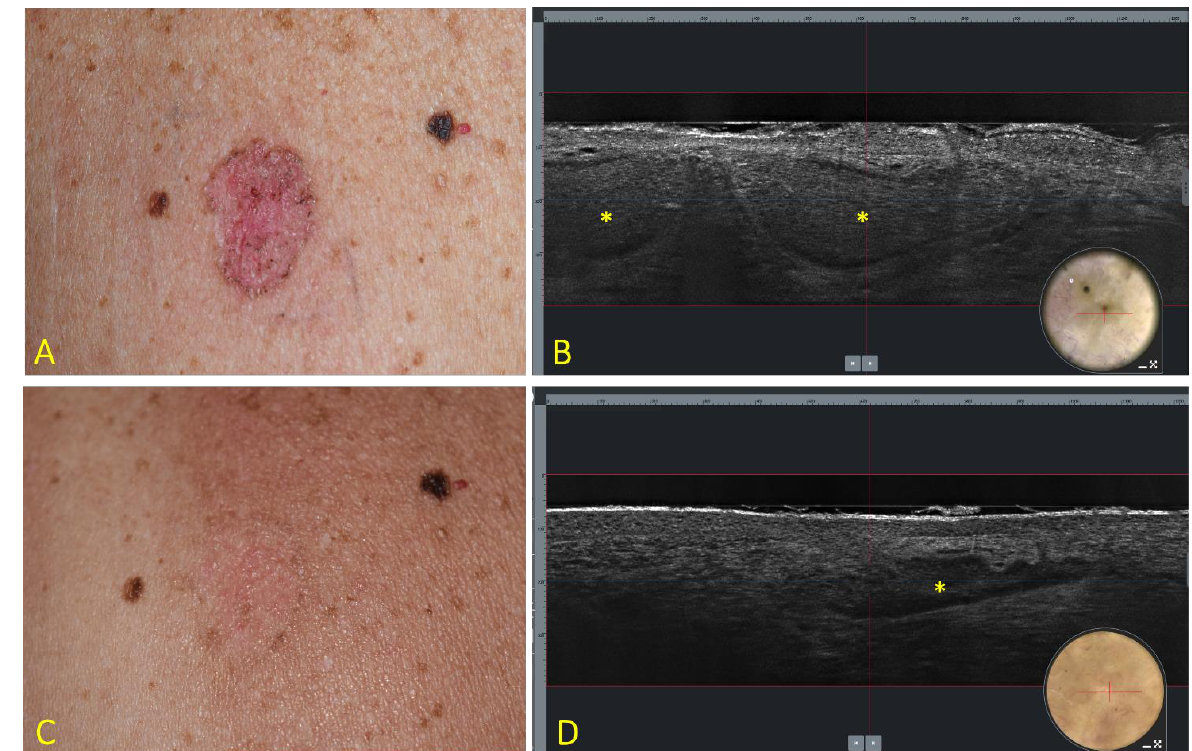
Figure 2. Superficial BCC of the trunk at baseline ( A , B ) and 4 weeks after the end of treatment with IQ 5% cream ( C , D ). ( A ) Clinical aspect showing a 18 × 12 mm, roundish, and reddish patch with pigmented areas. ( B ) LC-OCT vertical section (field of view: 1200 × 250 μm) showing the presence of lobules (asterisks) connected to the epidermis with an outer bright rim surrounding a middle dark rim, and an inner grey core with a “millefeuille” pattern. Insert: dermoscopy of the examined lesion (field of view: 1200 × 500μm); the red line corresponds to the vertical section. ( C ) Clinical disappearance of the lesion with mild residual erythema. ( D ) LC-OCT showing persistence of BCC lobules (asterisk). Insert: dermoscopy of the examined area (field of view: 1200 × 500μm); the red line corresponds to the vertical section.